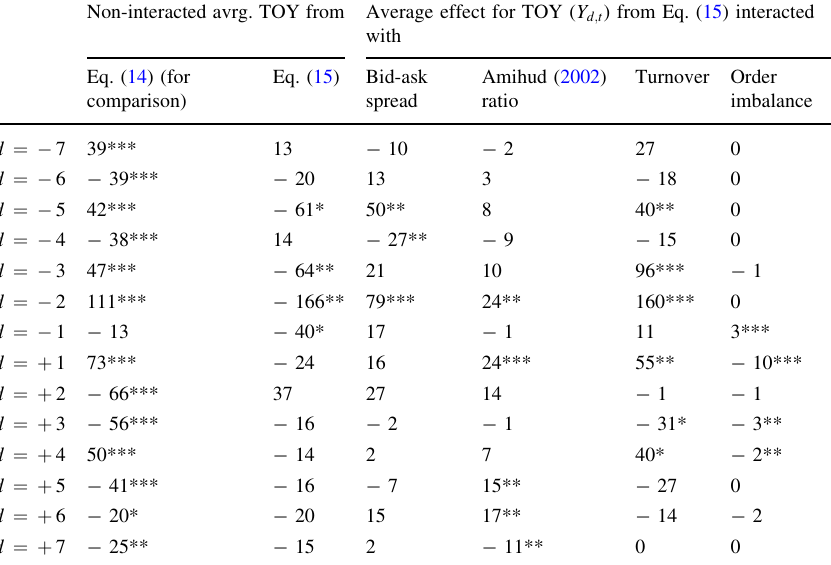
Table 6 Effects of liquidity and order imbalance on returns, part 3: turn of the year effect Non-interacted avrg. TOY from Average effect for TOY ( Y d ; t ) from Eq. (15) interacted with Eq. (14) (for Eq. (15) Bid-ask Amihud (2002) comparison) spread